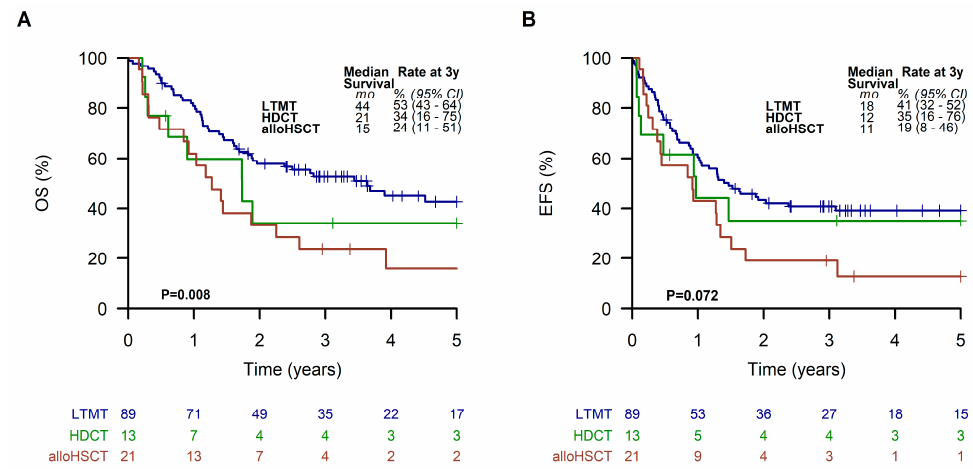
Figure 7. Overall survival ( A ) and event-free survival ( B ) of all patients receiving a metronomic long-term maintenance therapy (LTMT), allogeneic hematopoietic stem cell transplantation (alloHSCT), or high-dose chemotherapy (HDCT).